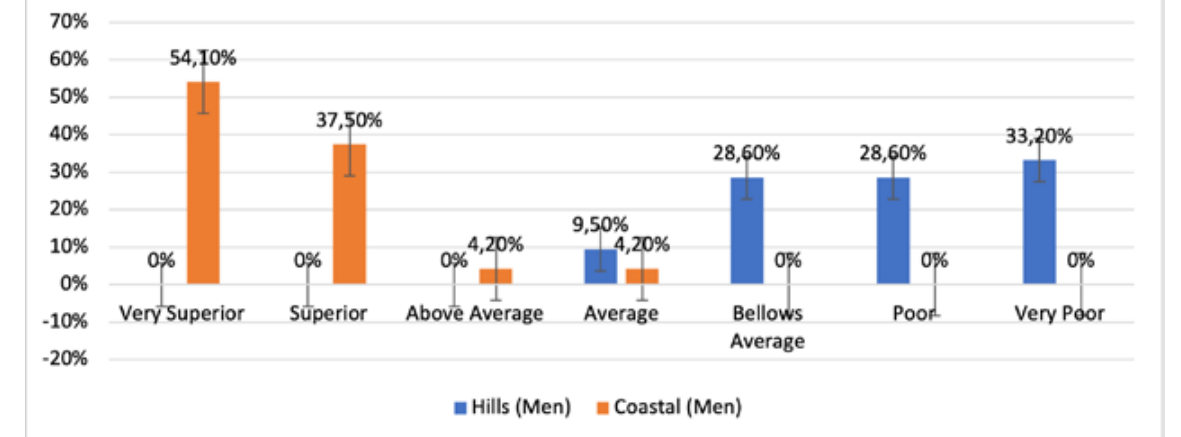
Figure 1. Description of Gross Motor